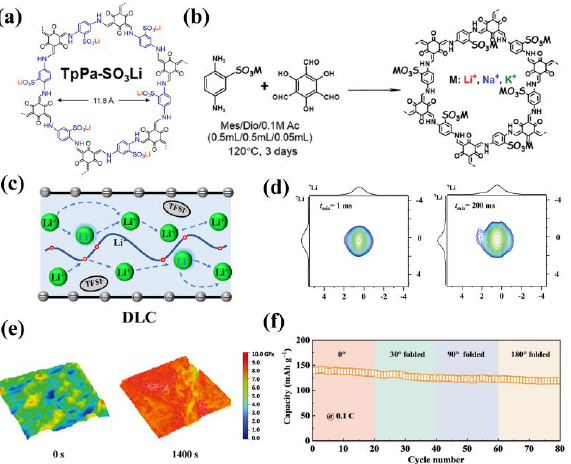
Figure 14. ( a ) Chemical structure of lithium sulfonated COF (TpPa − SO 3 Li). Reproduced with permission from Ref. [74], Copyright (2019), American Chemical Society; ( b ) Illustration of the pre − synthetic strategy for single − ion (Li + , Na + , K + ) conductive COFs. Reproduced with permission from Ref. [75], Copyright (2020), Royal Society of Chemistry; ( c ) Illustration of the Li + transport mode in DLC; ( d ) 2D 7Li – 7Li exchange spectra measured at 298 K for DLC at t mix = 1 ms and t mix = 200 ms; ( e ) Quantitative nanomechanical mappings for lithium metal at sputtering times of 0 s and 1400 s; ( f ) Cycling performance of a Li|DLC|LFP pouch cell at various degrees of bending deformation at 45 °C. Reproduced with permission from Ref. [76], Copyright (2022), John Wiley and Sons.